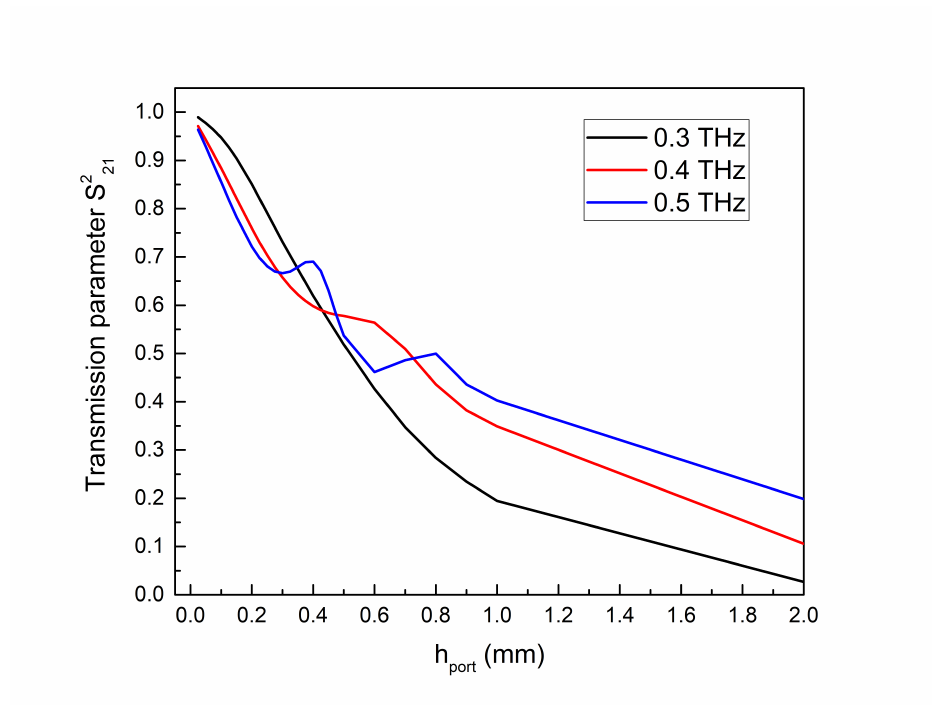
Figure 7. Transmission parameter dependence on the distance between THz radiation source and detector. The results are obtained for the power input of 50